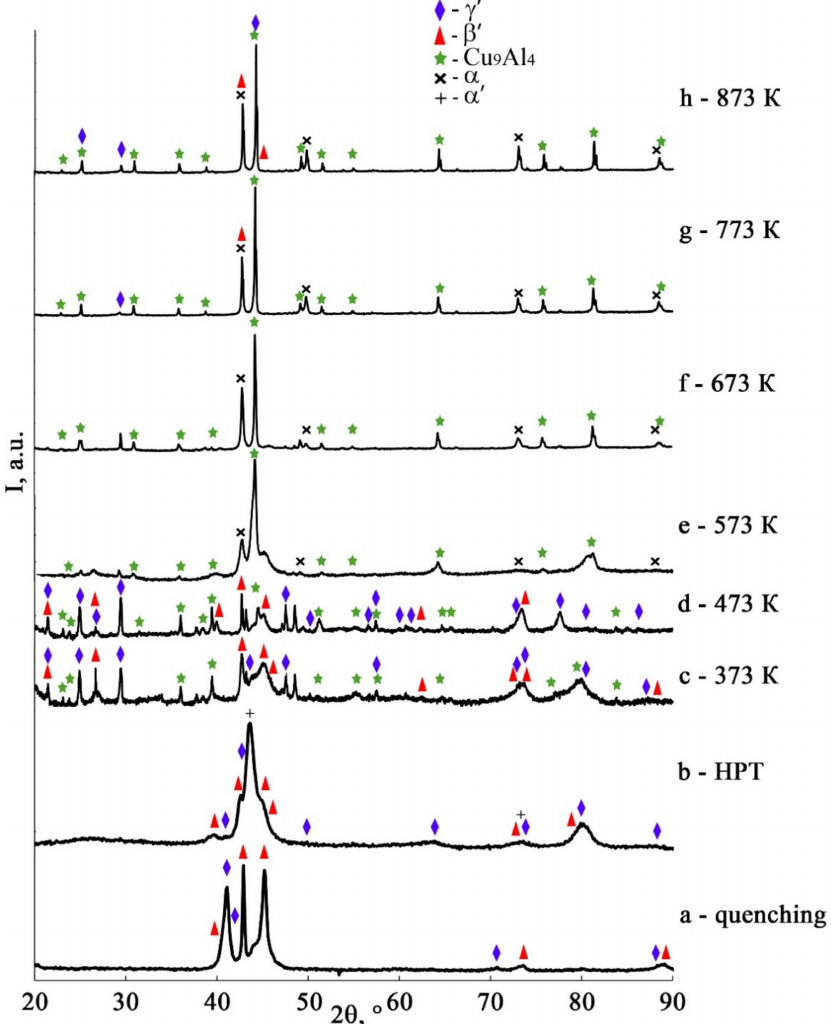
Figure 9. XRD spectra for the alloy Cu–14Al–3Ni after its ( a ) quenching, ( b ) HPT of 10 rev, and ( c – h ) HPT of 10 rev + annealing at 373 K–873 K, 30 min. Temperatures of measurements: ( a ) 200 K, ( b – h )